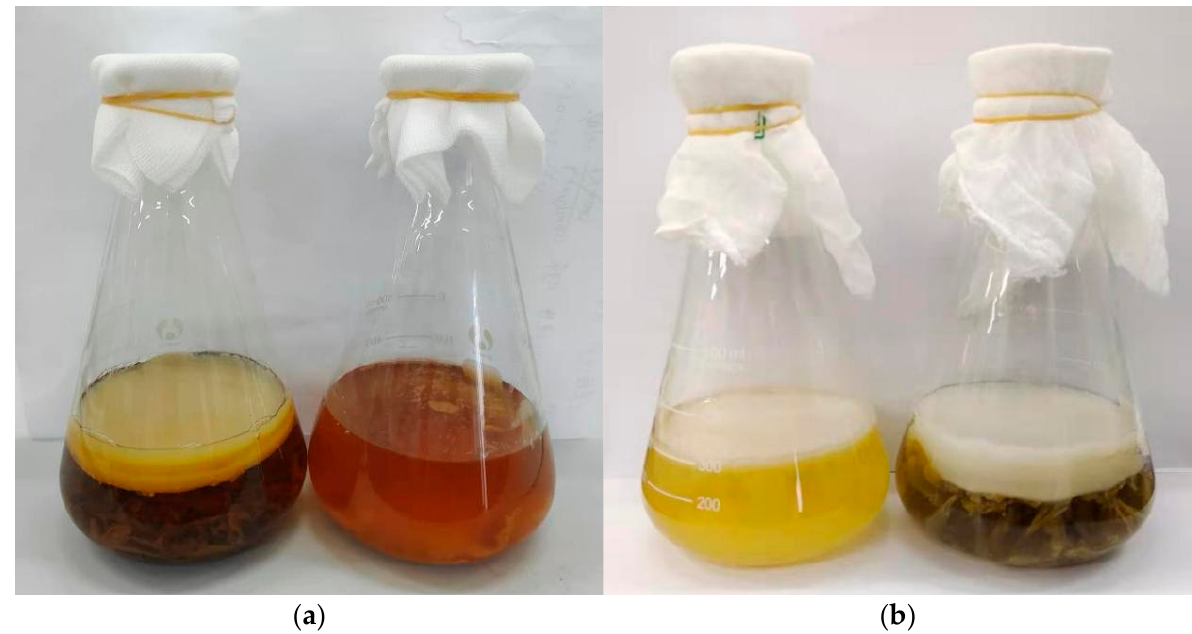
Figure 1. The appearance of kombucha produced by fermentation with or without tea residue. ( a ) kombucha from black tea with or without tea residue; ( b ) kombucha from green tea with or without tea residue.